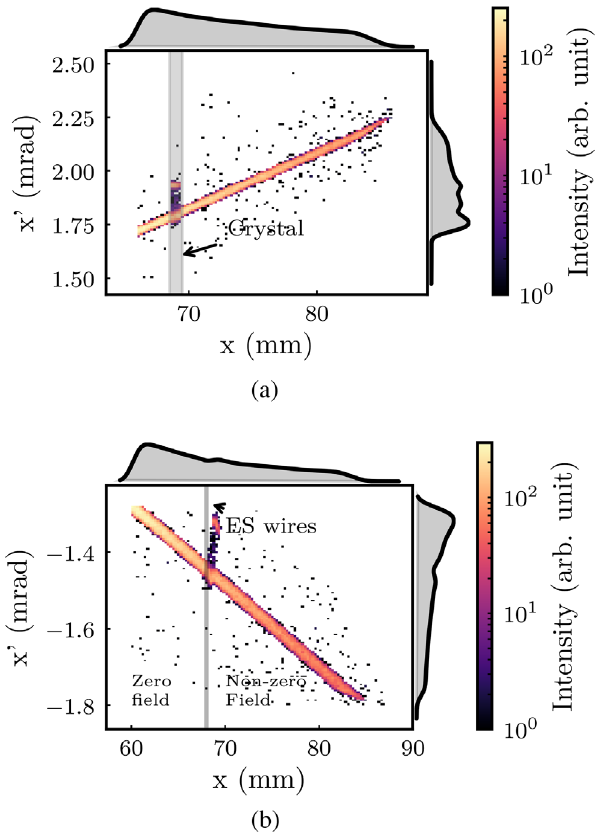
FIG. 10. Shadowing of ES with thin crystal. The phase space distribution at the crystal of width 0.8 mm (shaded) with the coherently channeled particles is plotted, together with the phase space distribution at extraction septum with particles missing the thin wire-array (shaded) on the high-field side and transported into the extraction line. (a) Crystal. (b) Electrostatic